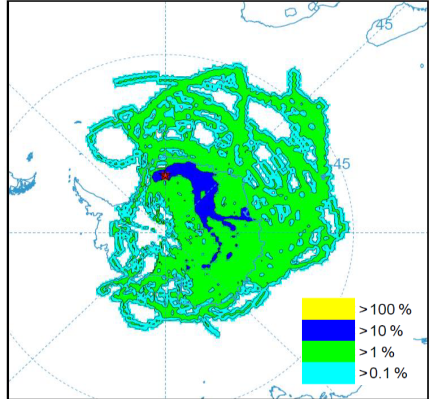
Figure 16. Daily 20-day backward trajectories (3-D approach, start- ing height 100m) during clear sky conditions in 2016 (doy 12 to doy 31, N = 80). Shown is the relative (percentage) number of tra- jectory intersections on a given grid cell (resolution 1 ◦ × 1 ◦